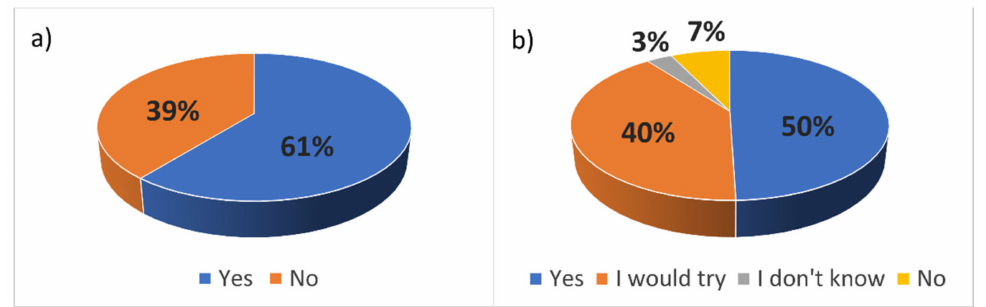
Figure 1. The evaluation of the need to implement AR functionality in a mobile navigation application: ( a ) Do you use an application supporting spending time by the water? ( b ) Would you use AR function in navigation application on the